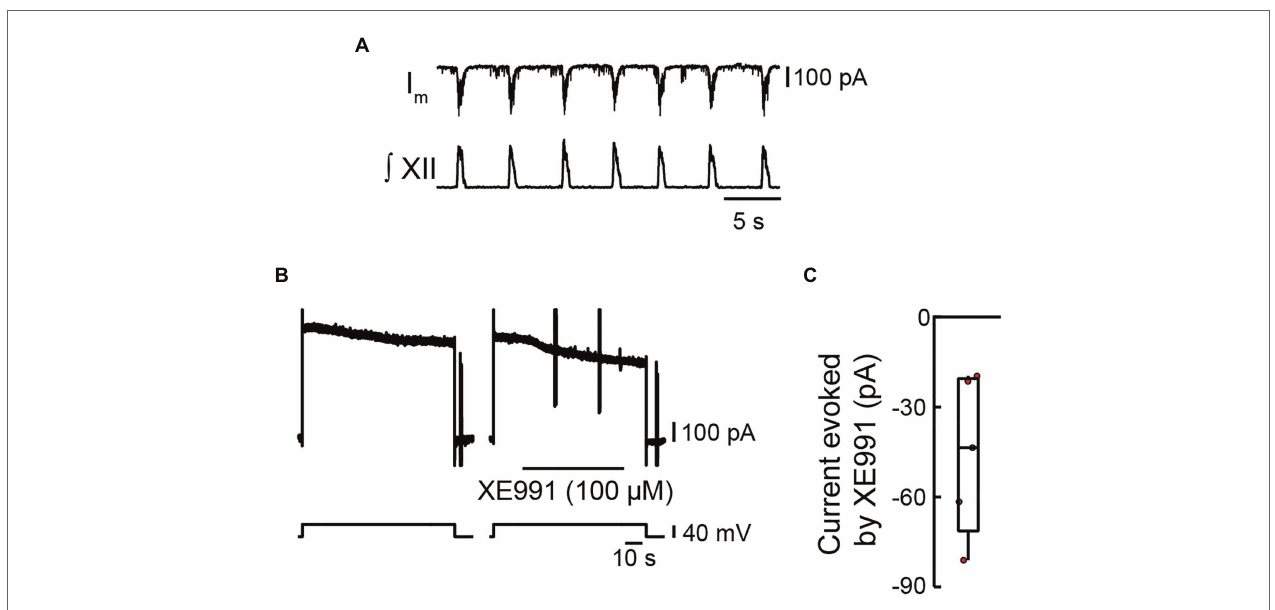
FIGURE 1 | Effects of locally applied XE991 on membrane current in inspiratory pre-Bötzinger complex (preBötC) neurons. (A) Voltage-clamp recording from an inspiratory preBötC neuron showing rhythmic synaptic inputs in phase with bursts of inspiratory motor output recorded from the XII nerve prior to bath application of tetrodotoxin (TTX; 0.5 μ M) and ZD7288 (10 μ M). (B) Voltage-clamp recording from the same neuron in (A) after the network was silenced via bath application of TTX and ZD7288, showing the current responses evoked by a depolarizing step from − 60 to − 20 mV for 90 s during control (left panel) and when XE991 is locally applied 20 s into the 90-s depolarizing step (right panel). (C) Group data showing current evoked in inspiratory preBötC neurons by local application of XE991 during a depolarizing step to − 20 mV (box plot: median and interquartile range; whiskers: 10th and 90th percentiles) and individual values (red circles, n = 5).